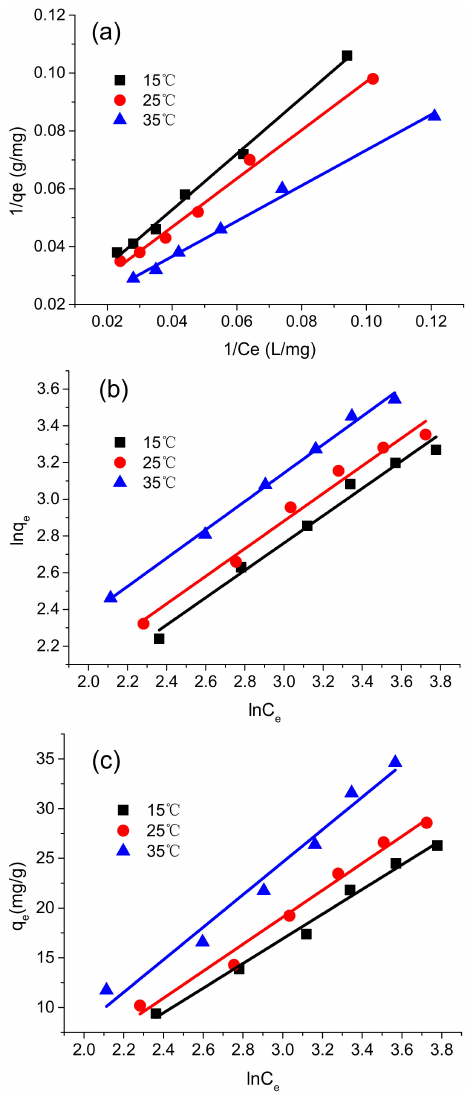
Figure 8. Fitting with isotherm models at different temperatures: Langmuir model ( a ); Freundlich model ( b ); and Temkin model ( c ). Table 1. Isotherm model parameters of the Langmuir, Freundlich, and Temkin models for HBP- g